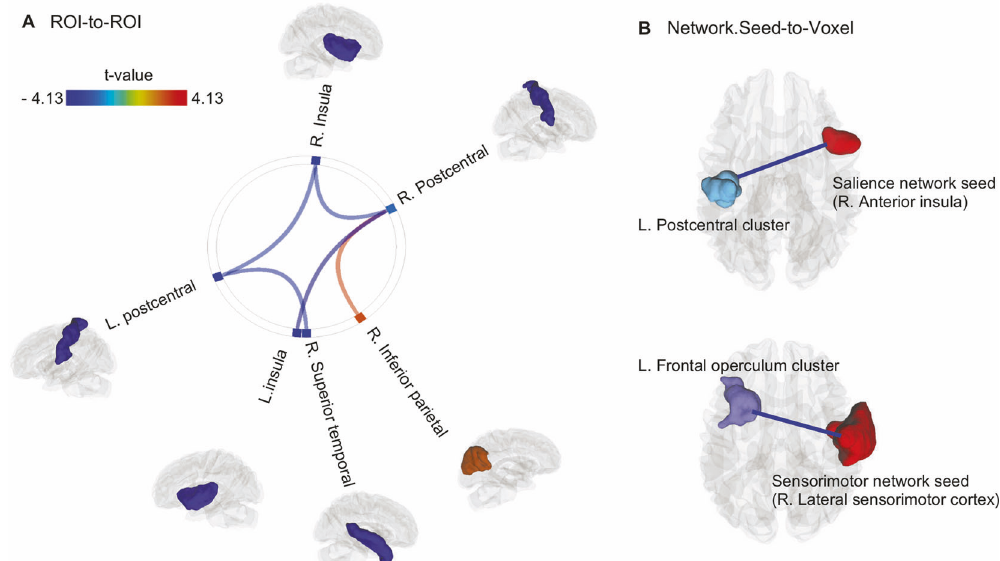
Fig. 2 Functional connectivity differences between HCMV + and HCMV − . A Illustration of anatomical structural (Desikan-Killiany atlas)- based ROI-to-ROI analyses fi ndings ( p FDR < 0.05). The fi gure represents connections were increased (orange-red color) or decreased (green- blue color) connectivity was found in HCMV + relative to HCMV − participants. B Functional network-based Seed-to-Voxel analyses identi fi ed two FC pairs that were signi fi cantly lower in HCMV + relative to HCMV − participants (voxel-level p uncorrected < 0.001, cluster level p FDR < 0.05). That is 1. from right anterior insula for the salience network to left postcentral cluster (cluster size = 274 voxels, peak coordinate x, y, z = − 36, − 16, + 50); 2. from right lateral sensorimotor cortex for the sensorimotor network to the left frontal operculum cluster (cluster size = 405 voxels, peak coordinate x, y, z = − 36, + 22, + 08). The ROI/seed regions and the identi fi ed clusters were exported as binary maps and rendered using DSI-studio for visualization. Effect sizes (standardized beta coef fi cient) ranged from − 0.57 to − 0.99. Please see Table 2 for